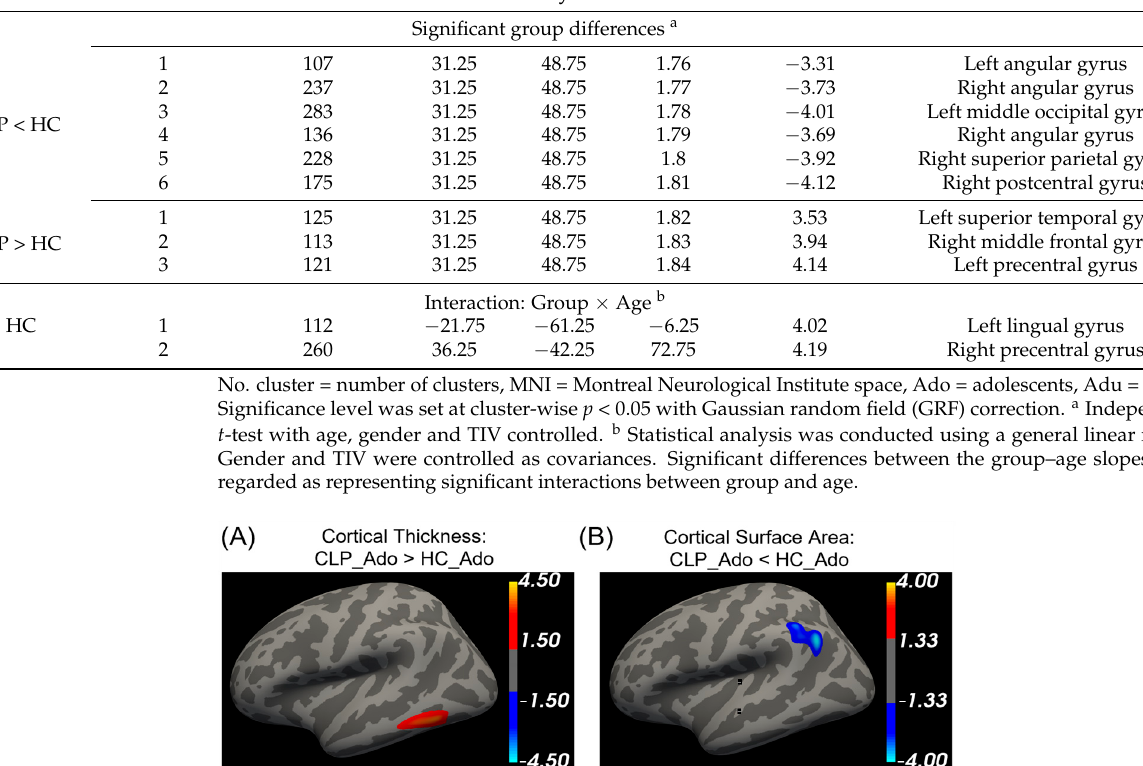
Figure 3. Significant group differences using surface-based morphometry analyses. ( A ) CLP adolescents have an increased cortical thickness compared to HC adolescents in the left inferior temporal cortex, which is colored red–yellow; ( B ) compared with HC adolescents, CLP adolescents have a decreased cortical surface area in the left inferior parietal cortex, which is colored blue. CLP_Adu = adults with cleft and palate (CLP), HC_Adu = healthy control adults, CLP_Ado = children and adolescents with CLP, HC_Ado = healthy children and adolescents. Gender and age were regressed out as covariates, and significance was set at cluster-wise p < 0.05 using Monte Carlo simulation with 5000 iterations.